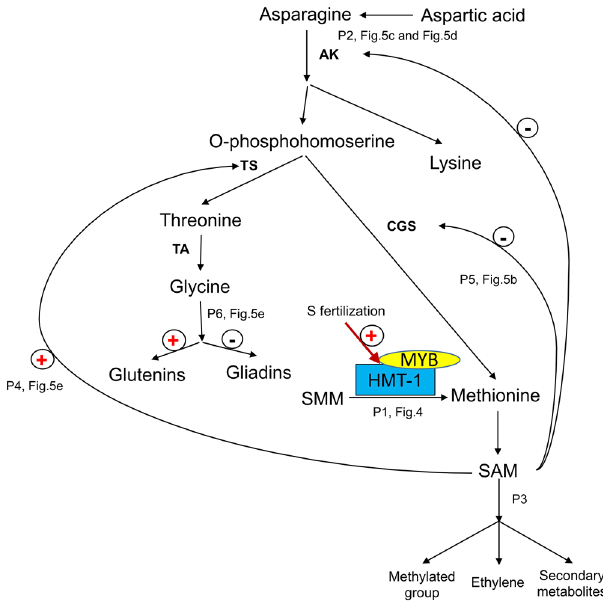
Fig. 6 Sulfur-mediated regulatory network for gluten